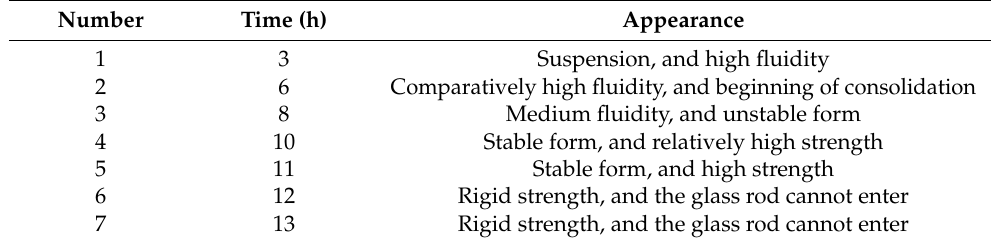
Table 3. Consolidation time and consolidation strength.